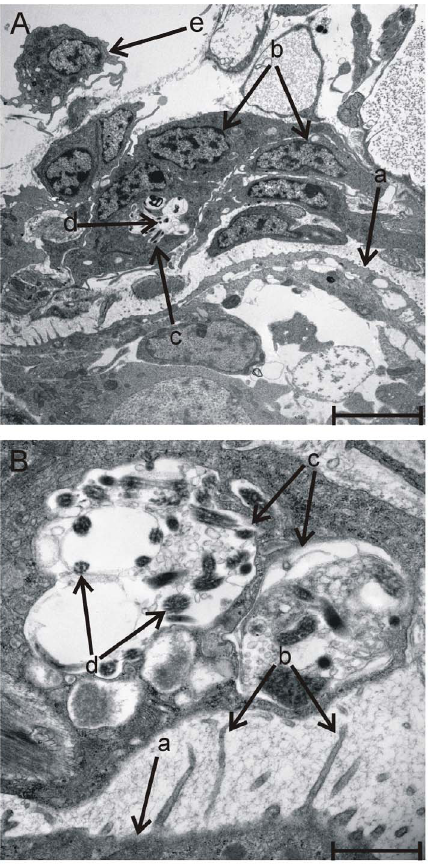
Figure 2. Trichobilharziaregenti mother sporocysts within the tissue of Radixlagotis 15 h p.e.; TEM images. (A) Mother sporocyst of T. regenti (a) is surrounded by haemocytes with remarkable nuclei (b). Phagosome (c) of one haemocyte with internalised microtubular aggregates (d) is visible (B in detail). Another haemocyte (e) is located near the parasite. Scale bar=5 m m. (B) Microvilli (b) are present on the surface of T. regenti mother sporocyst (a). Haemocyte adjacent to the sporocyst contains phagosomes (c) with microtubular aggregates (d).